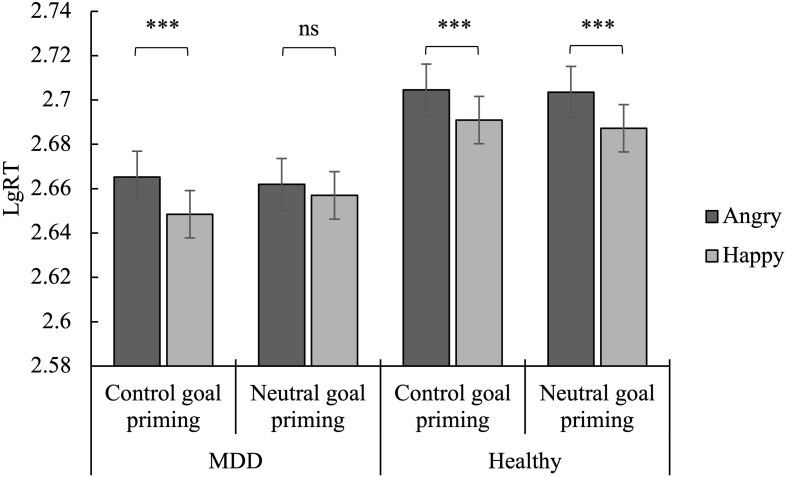
Mean reaction time of Go trials as a function of emotion, priming, and group. ∗∗∗p < 0.001; ns, no significance.